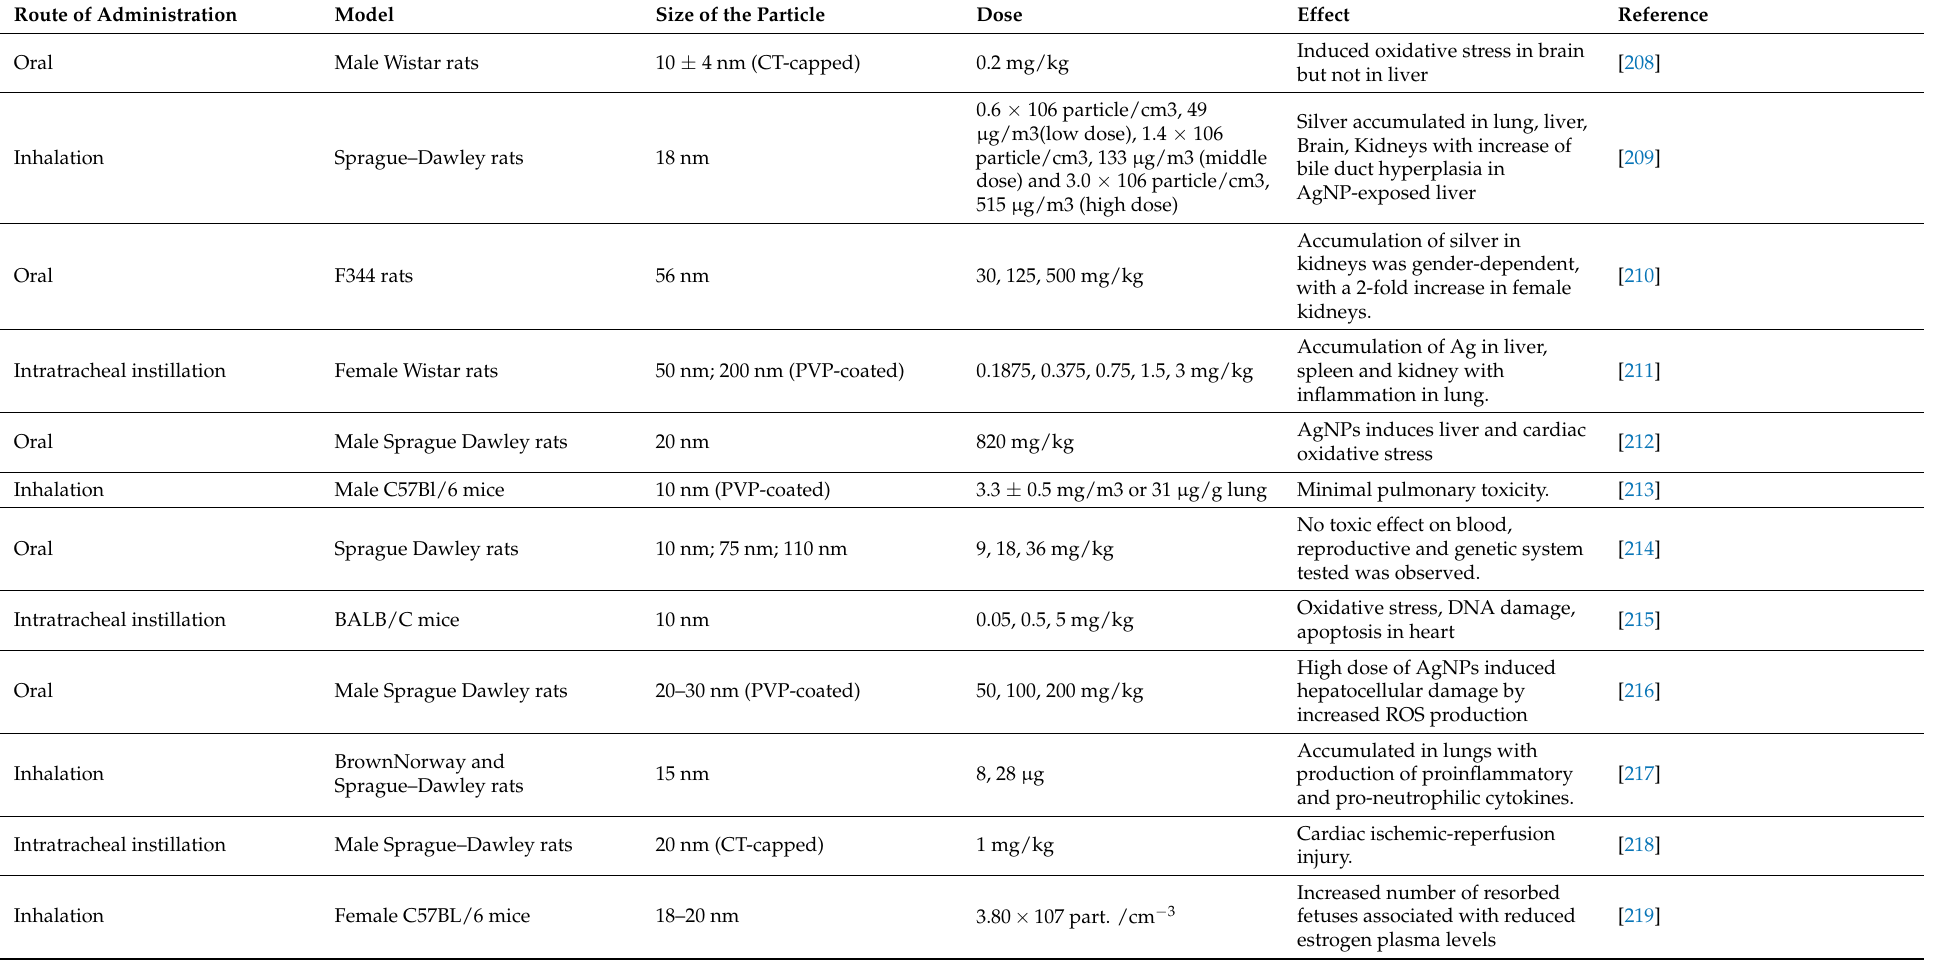
Table 3. Toxicity of AgNPs in in vivo